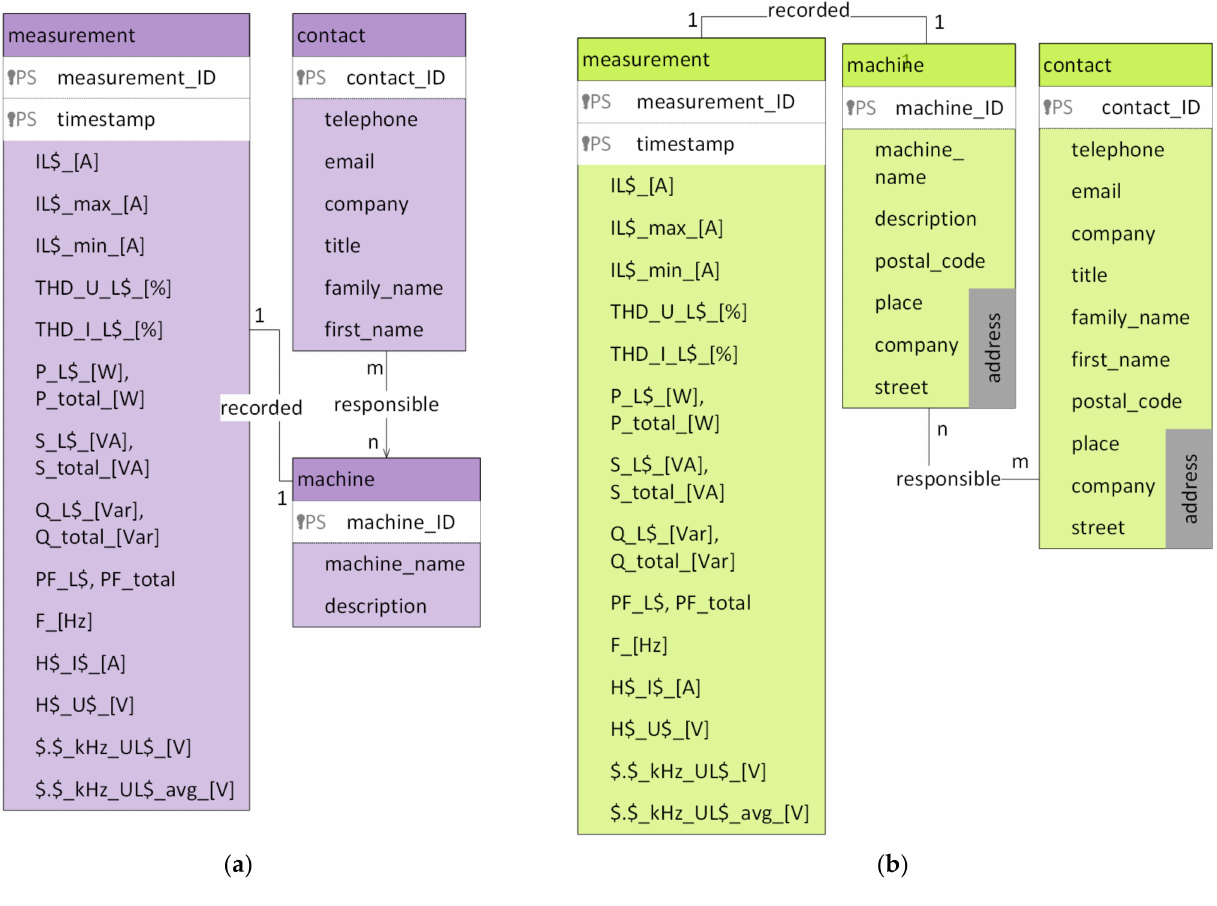
Figure 9. ( a ) Entity relationship model of the PostgreSQL DB. ( b ) Entity relationship model of the MongoDB